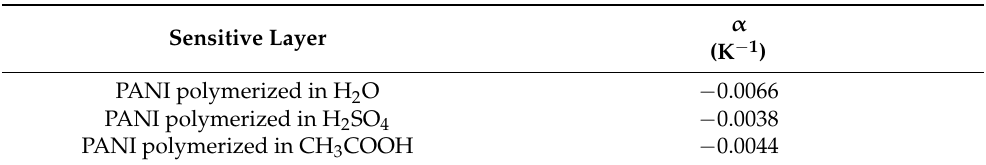
Figure 8. Temperature dependencies of sensitive layers ( a ) and current-voltage characteristics of sensitive layers ( b ). Table 2. Values of the average temperature coefficients of the sensitive polyaniline layers in a temperature range from 23 °C to 80 °C.